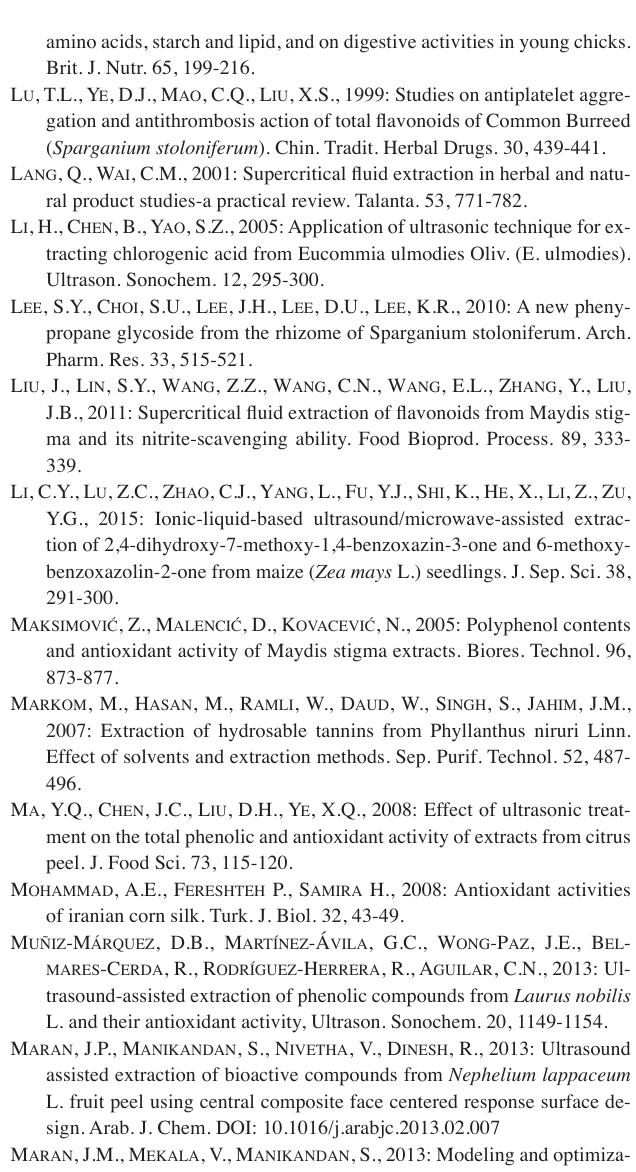
Fig. 3: HPLC-MS/MS chromatograms of MF polyphenols extract and analysis mass spectrum of the sixteen phenolic compounds. MS: (1) Benzoic acid; (2) Gentisic acid; (3) Epicatechin; (4) B2 Benzoic acid; (5) syringic acid; (6) Catechin; (7) Catechin gallate; (8) Quercetin; (9) Quercetin-3-O-rhamnoside; (10) Rutin;(11) chlorogenic acid; (12) Gallic acid; (13) Gallic acid-6 hydroxy diphenyl- pyran glucose; (14) Ellagic acid; (15) Epicatechin trimer; (16) Epicatechin